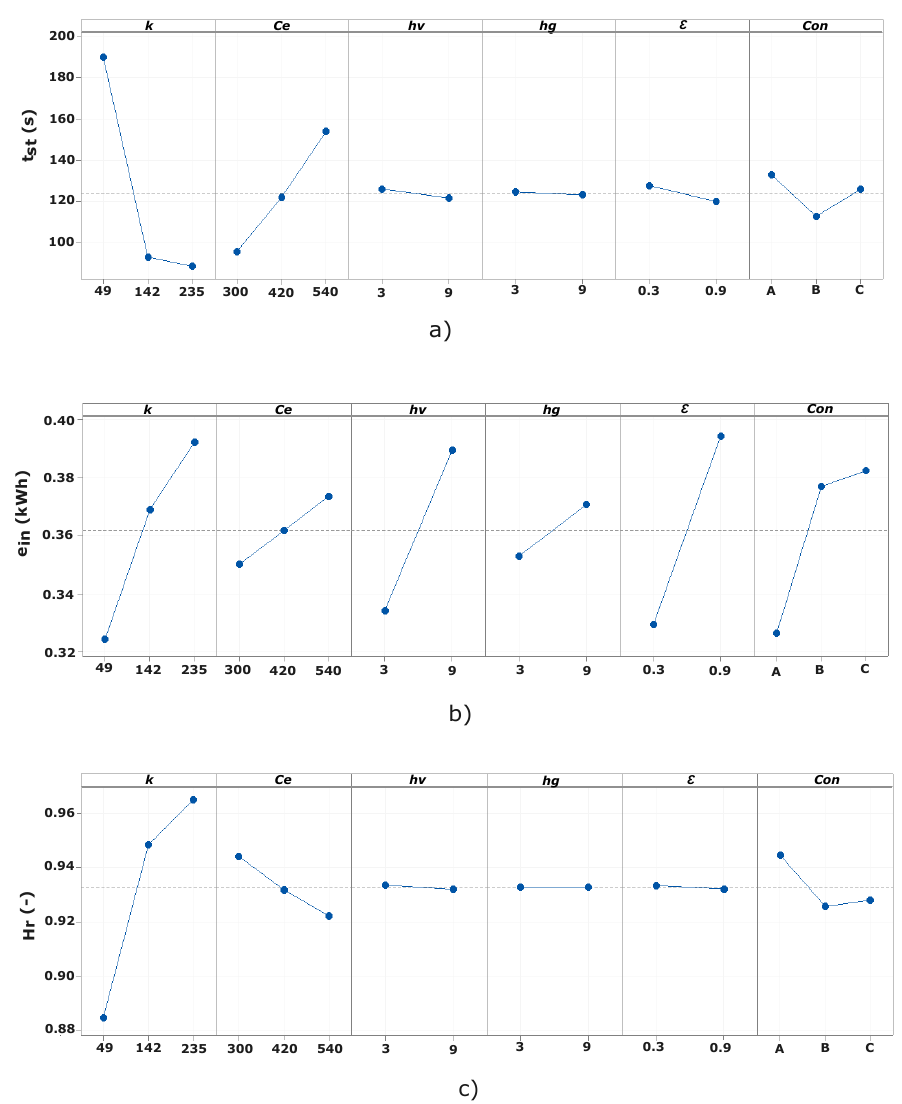
Figure 9. Main effects plot of conductivity ( k ), specific heat ( c e ), pan and glass convective coefficients ( h v and ( h g )), emissivity ( (cid:101) ) and concavity ( Con ) for the responses: time to reach the steady state ( a ), supplied energy ( b ) and temperature homogenisation along the radius in the second 60 of the cooking ( c ). The units of the parameters are conductivity (W/mK); specific heat (J/kgK); convective coefficients (W/m 2 K); emissivity (-); and concavity